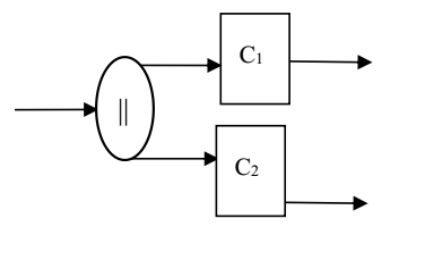
Figure 4. The Concurrence relation